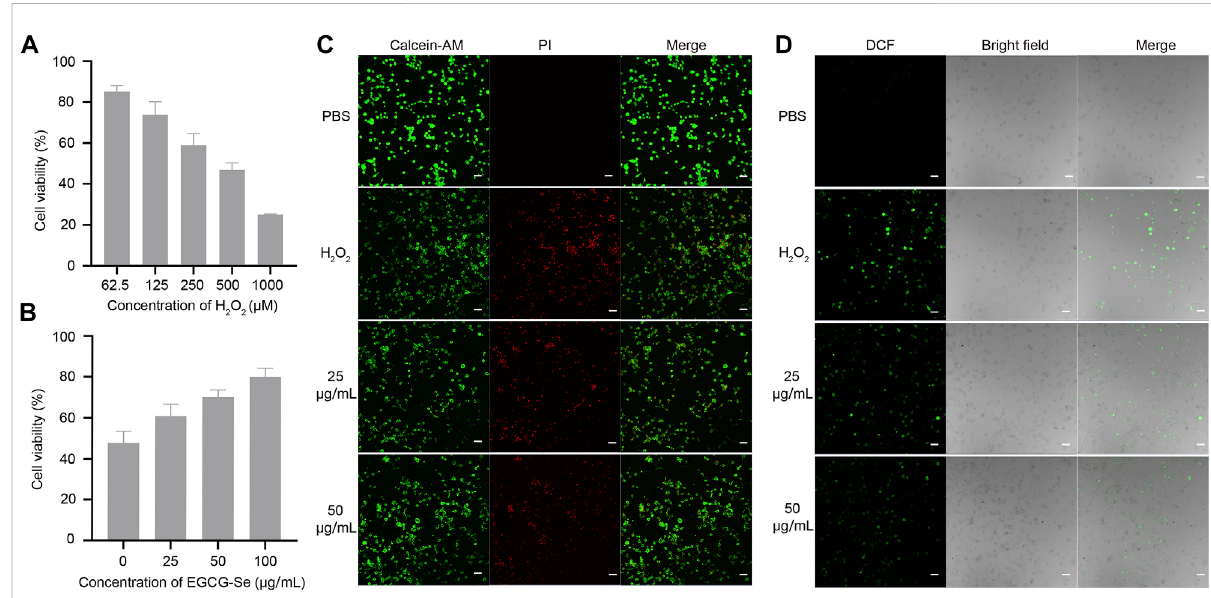
FIGURE 3 Epigallocatechin-3-gallate selenium nanoparticles (EGCG-Se NP) can protect PC12 cells from H 2 O 2 -induced damage. (A) H 2 O 2 -induced damage effect of PC12 cells. (B) EGCG-Se NP increased PC12 cell viability under 500 μ m H 2 O 2 -induced oxidative damage in a dose-dependent manner. (C) Live/deadstainingofPC12cellsunderdifferentconditions.Scalebar=20 μ m. (D) Dichloro fl uorescein(DCF)diacetatestainingtodetect intracellular reactive oxygen species in PC12 cells. PBS, phosphate-buffered saline; PI, propidium